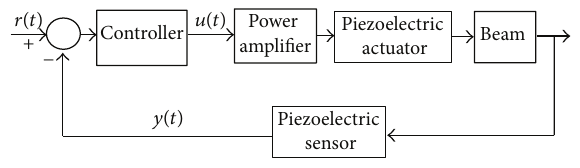
Figure 6: Controlled